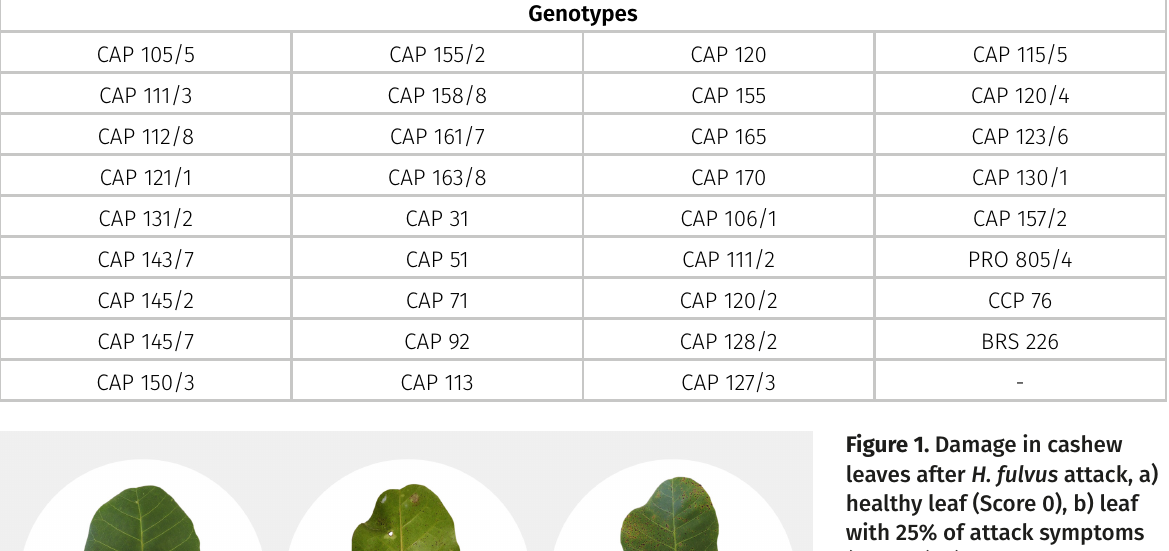
Figure 1. Damage in cashew leaves after H. fulvus attack,